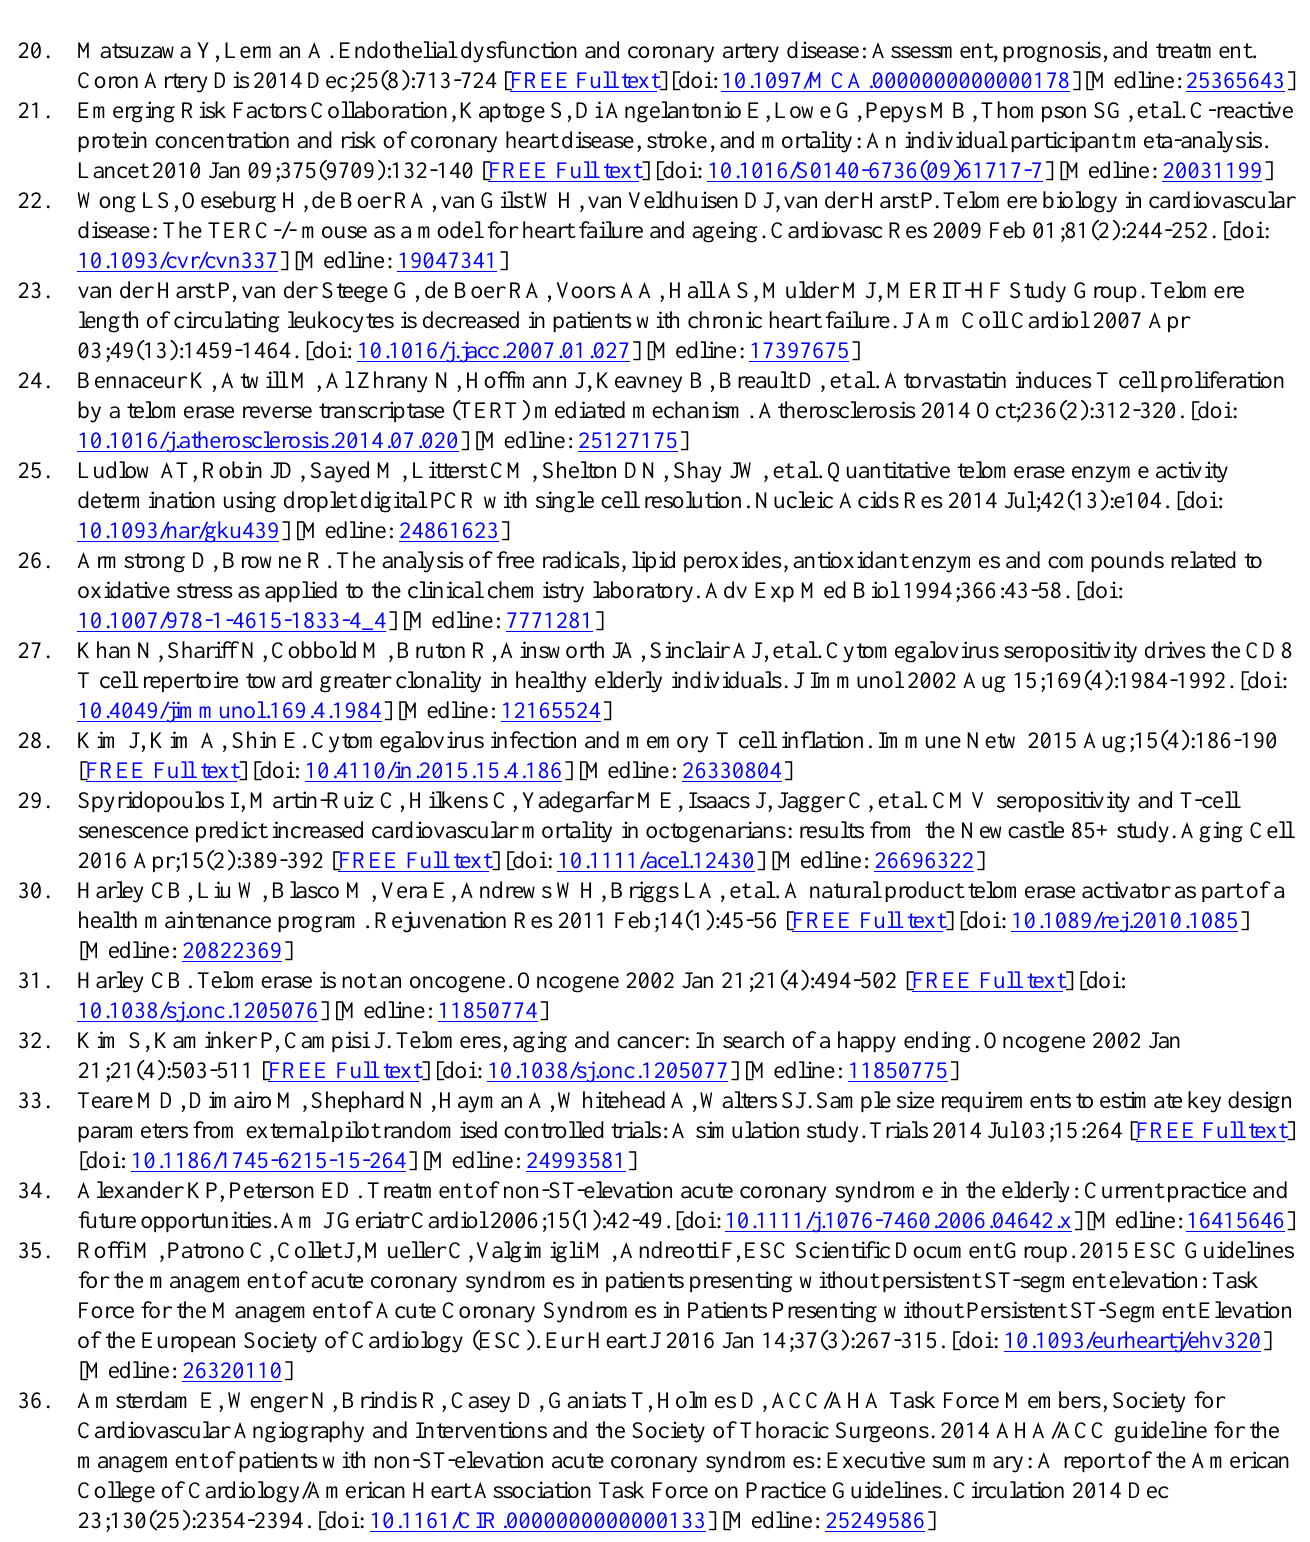
AE: adverse event CAD: coronary artery disease CAG: cycloastragenol CANTOS: Canakinumab Anti-Inflammatory Thrombosis Outcomes Study CHD: coronary heart